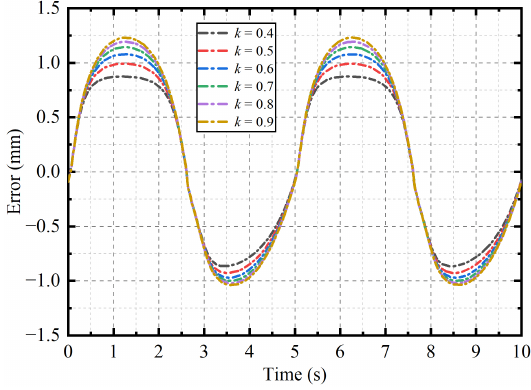
Figure 23. Tracking error at different user-defined k .